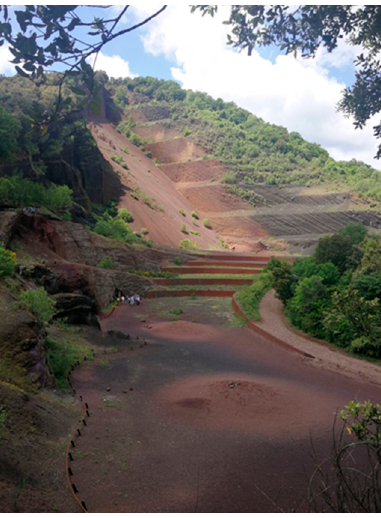
Figure 2. Tephra quarry at the Croscat volcano restored in 1995. This is one of the outcrops of interest for the Natural Park, and has a special protection regulation. Table 1. Chronology for the preservation of the La Garrotxa volcanoes, which illustrates how they passed from an extractive activity to a natural reserve and a touristic attraction.